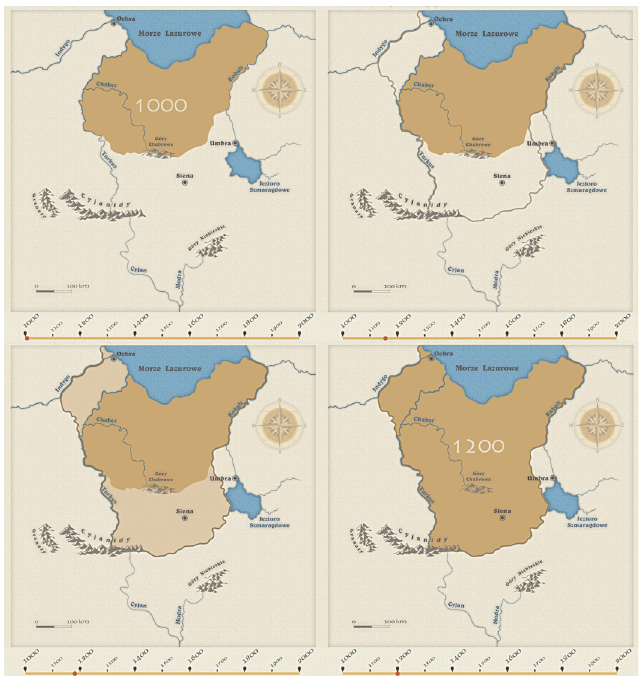
Fig. 2. Selected frames of abrupt with decay effect